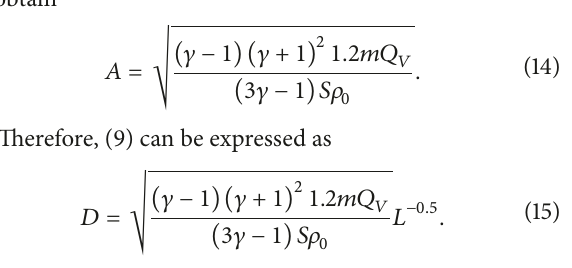
Figure 2: Comparison between theoretical calculations and exper- imental results for the temperature